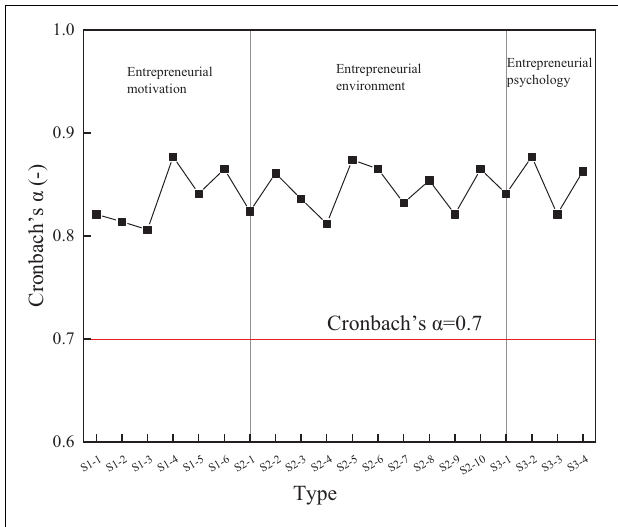
FIGURE 4 | The calculation results of Cronbach’s α coefficient on the scale.